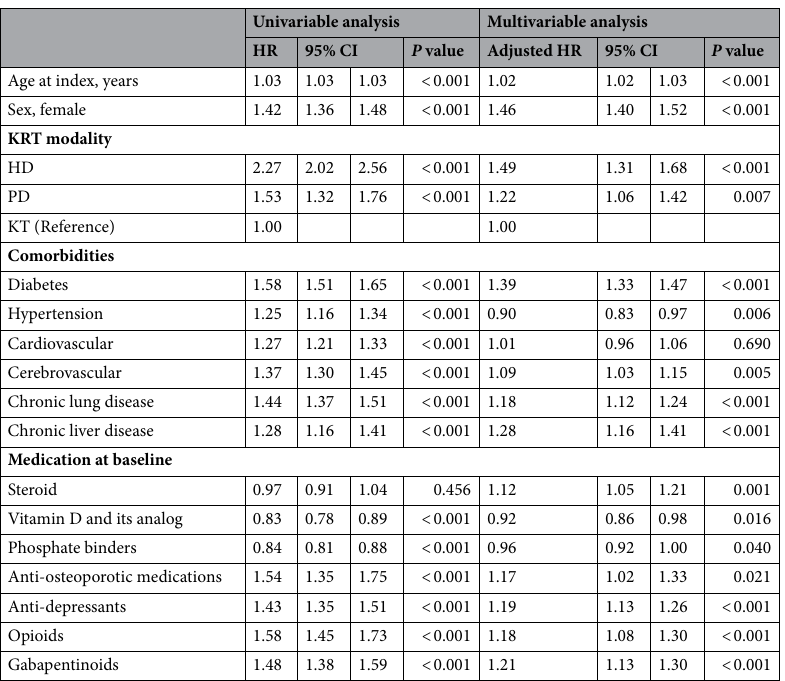
Table 4. HR and their 95% CI based on univariable and multivariable Cox proportional-hazards regression model. CI confidence interval, HD hemodialysis, HR hazard ratio, KRT kidney replacement therapy, KT kidney transplant, PD peritoneal